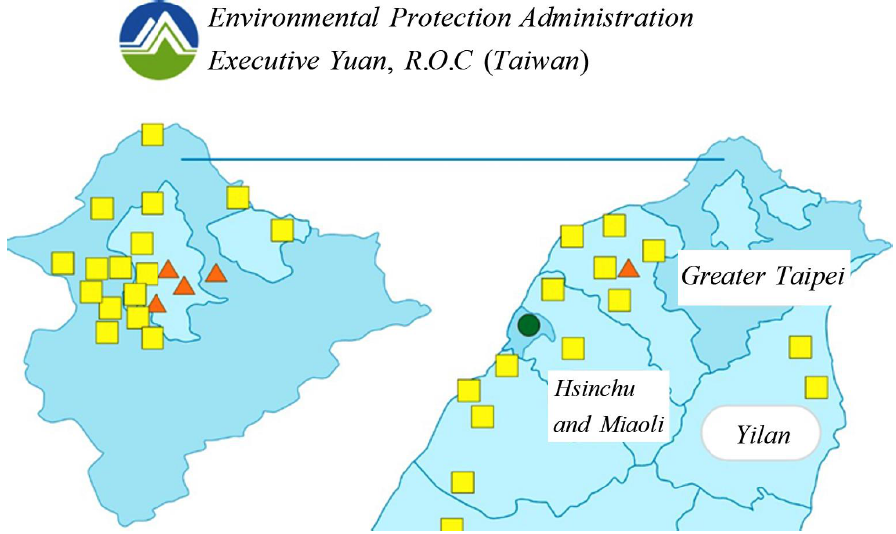
Figure 6. Location of air quality measurement stations in the